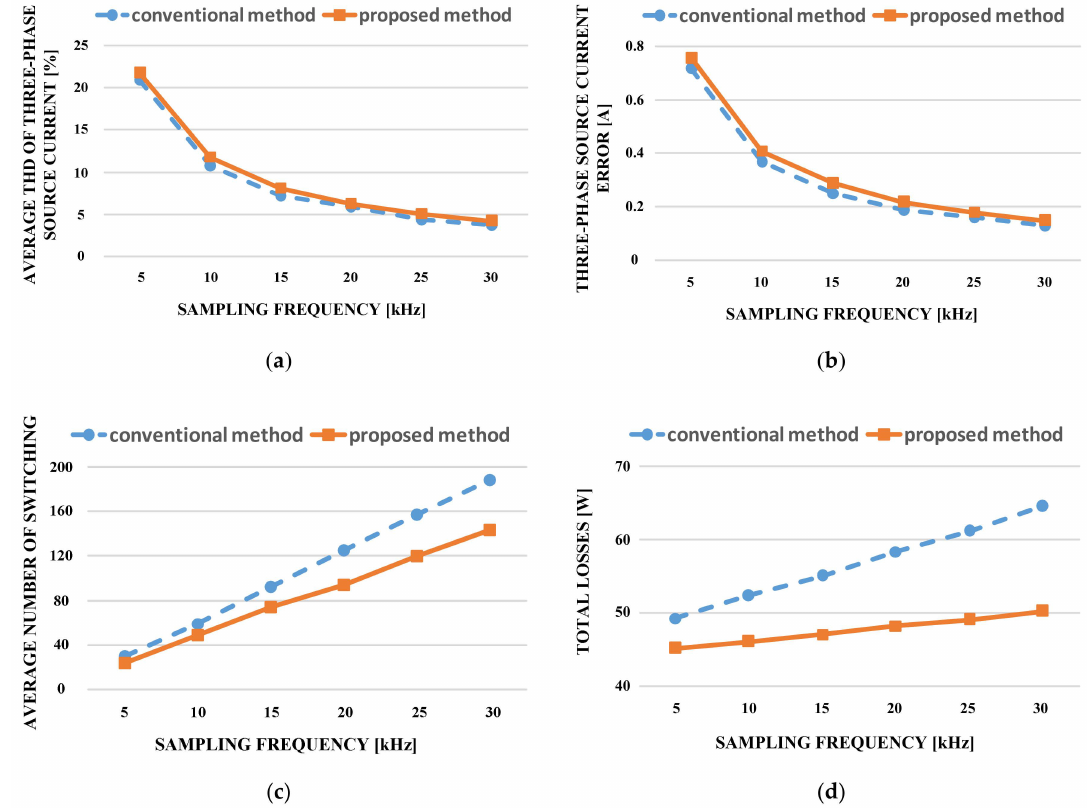
Figure 14. Performance comparison obtained from the conventional algorithm and the proposed algorithm vs. sampling frequency: ( a ) Average total harmonic distortion (THD) of three-phase source current; ( b ) three-phase source current error; ( c ) average number of switching; and ( d ) total losses